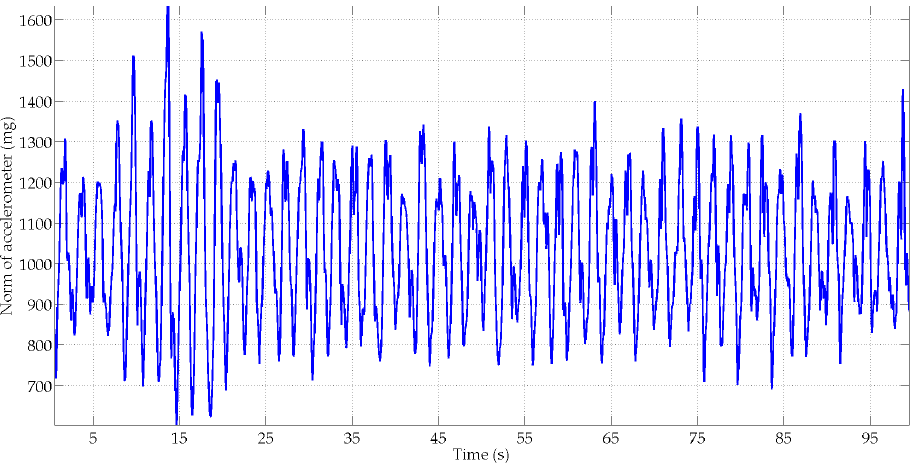
Figure 5. Illustration of the accelerometer’s norm for subject S1 in the texting Figure 5 . Illustration of the accelerometer’s norm for subject S1 in the texting scenario.